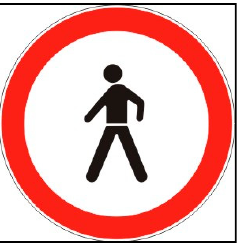
Figure 2. Traffic sign “No pedestrians” (II-17).